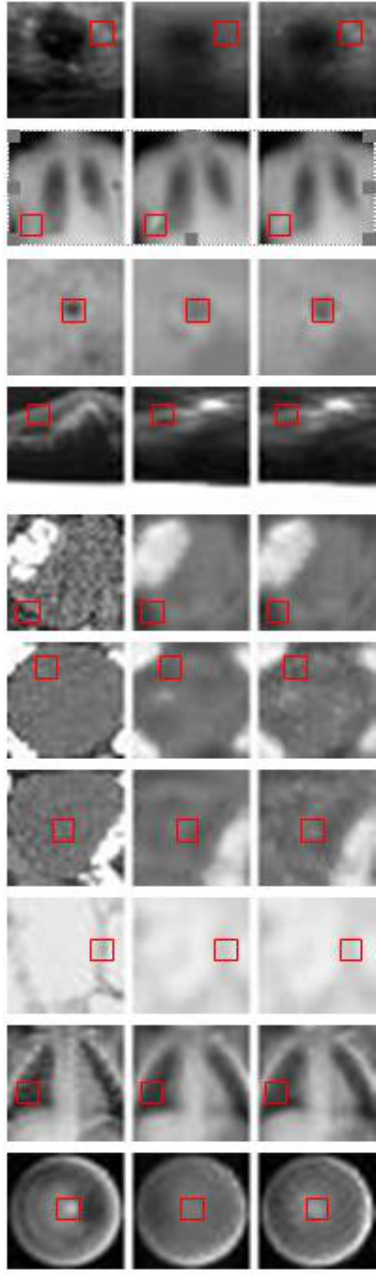
Figure 25. Marked reconstruction images on the MMNIST data